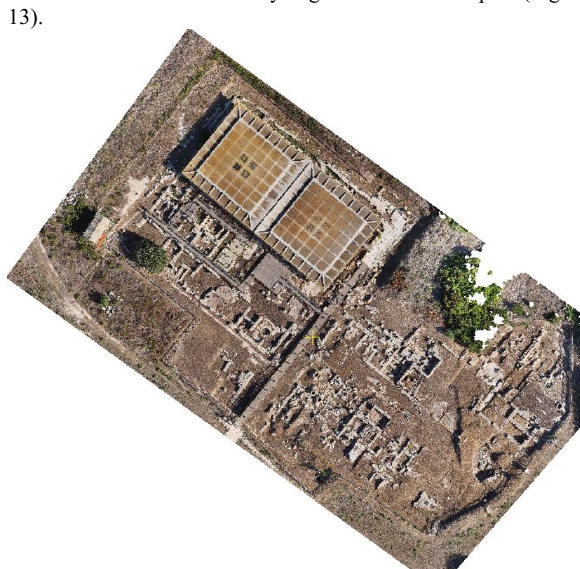
Figure 12. UAV 3D model of the whole Insuale archaeological area with the covered Roman Domus